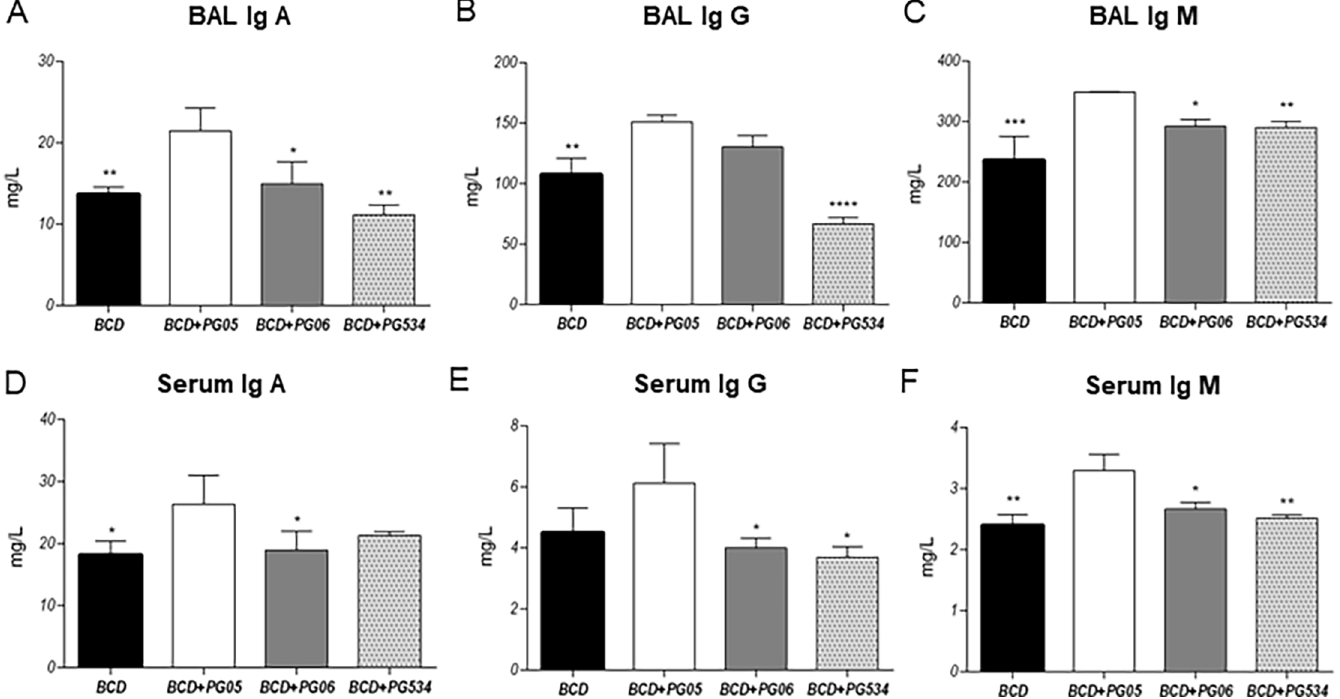
Fig 8. Effect of lactobacilli peptidoglycans on anti-pneumococcal antibodies levels after Streptococcus pneumoniae infection in malnourished mice. Immunocompromised-malnourished mice were replete for 7 days with a balanced conventional diet (BCD) or BCD supplemented with peptidoglycans from Lactobacillus rhamnosus CRL1505 (BCD+PG05), L . plantarum CRL1506 (BCD+PG06) or L . rhamnosus CRL534 (BCD+PG534), and then challenged with S . pneumoniae . The levels of antibodies were studied fifteen days after the pneumococcal challenge. (A) Levels of anti-peumococcal IgA, (B) IgG and (C) IgM in broncho- alveolar lavages. (D) Levels of anti-peumococcal IgA, (E) IgG and (F) IgM in serum. Results represent data from three independent experiments. Results are expressed as mean ± SD. Asterisks represent statistical differences compared with BCD+PG05 group. (cid:3) p < 0.05, (cid:3)(cid:3) p < 0.005, (cid:3)(cid:3)(cid:3) / (cid:3)(cid:3)(cid:3)(cid:3) p (cid:20) 0.001.